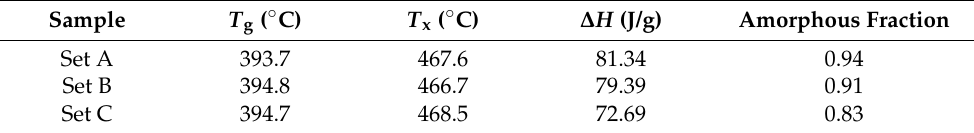
Figure 2. ( a ) XRD patterns of Sets A–C. ( b ) DSC results of the samples manufactured by Sets A–C parameters using a heating rate of 20 ◦ C/min, ( c ) back-scattered electron (BSE) image of the X-Z cross-section of Set A, and (d ) higher magnification of region d in ( c ) indicating the presence of nanocrystals. The light-colored rectangular features are due to contamination. Table 2. DSC results (using a heating rate of 20 ◦ C/min) of samples manufactured with Sets A-C parameters. The amorphous fraction is calculated by dividing the enthalpy of crystallization ( ∆ H ) of each Set by the ∆ H value of the virgin powder, which was 86.9 J/g in Ref. [43].